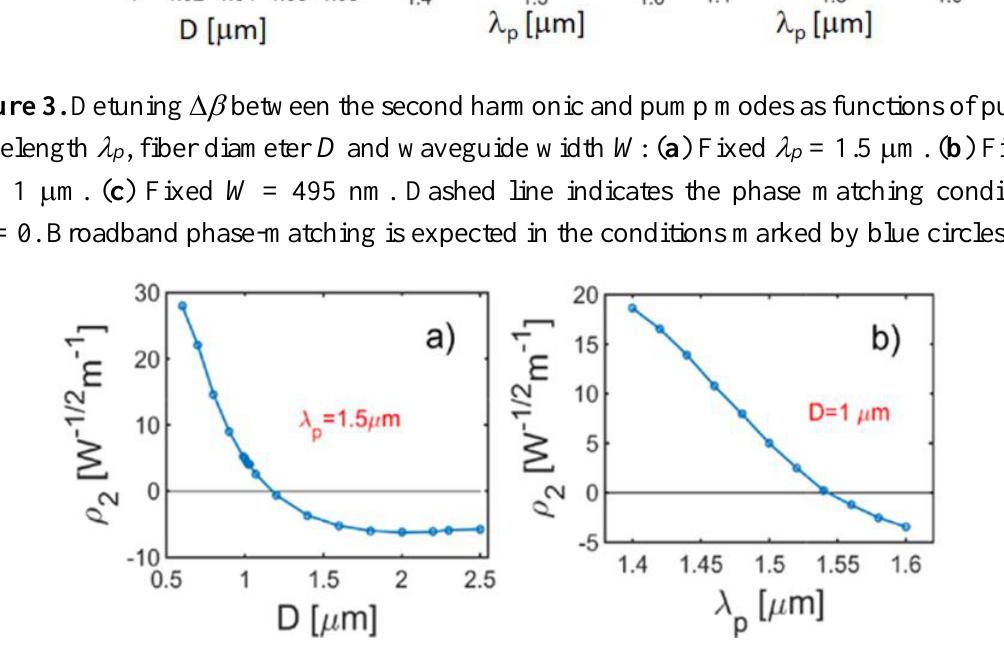
Figure 4. Nonlinear coefficient as function of the fiber diameter ( a ) Pump wavelength. ( b ) For the case of perfectly matched fundamental and second harmonics, cf. dashed curves in Figure 3a,b,